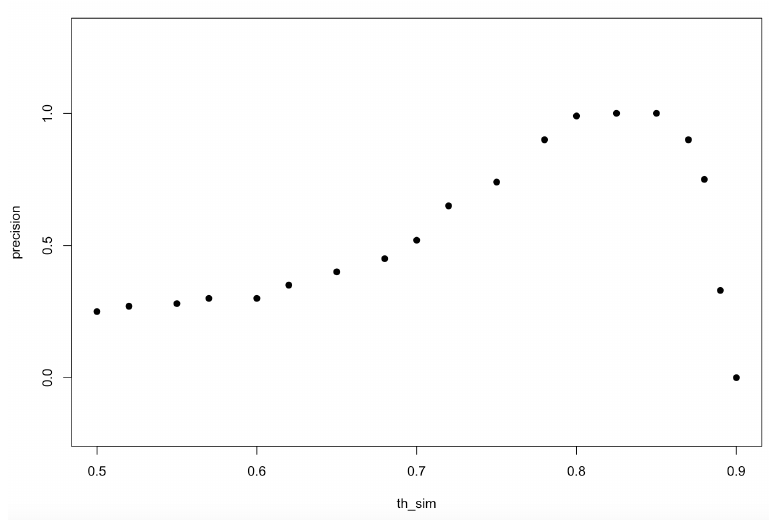
Figure 4. Sensitivity of precision w.r.t. threshold th_sim